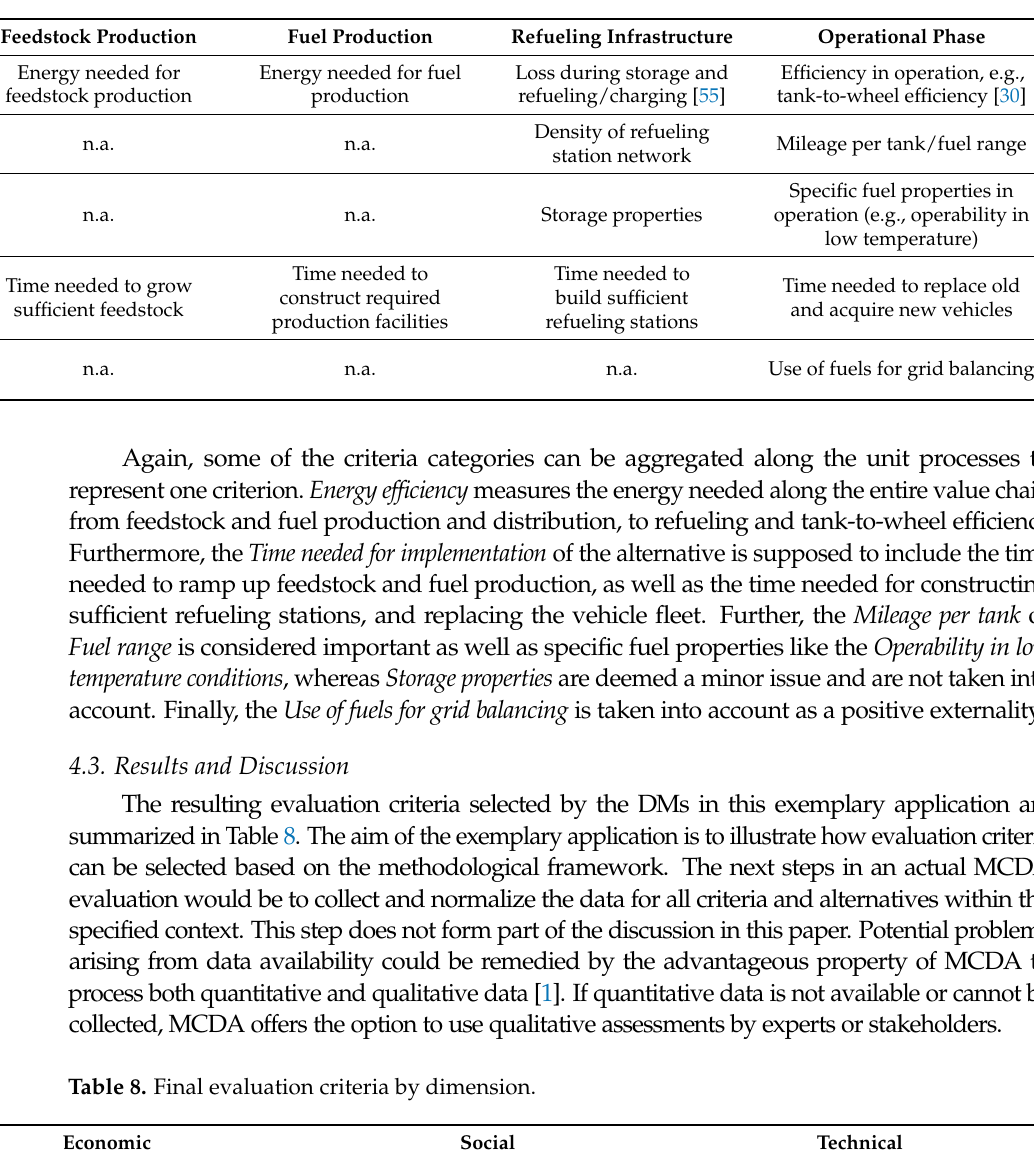
Table 7. Technical criteria categories developed along the unit processes.